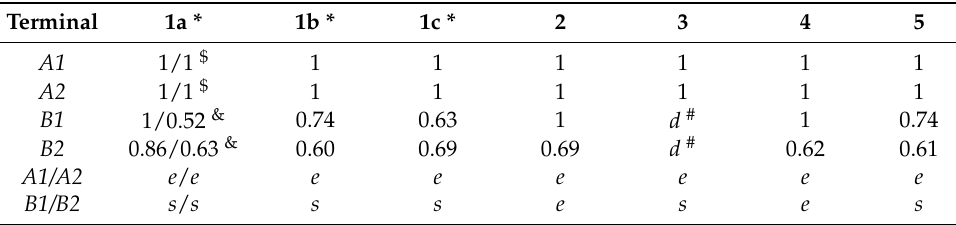
Figure 3. Relative positions in a chain and conformations of terminal ethylene groups for independent BEDT-TTF radical cation A ( left ) and B ( right ) in salt 5 . Main positions for disordered ethylene groups of B are colored cyan and complementary are colored navy. The conformation is eclipsed for A and staggered for B. Thermal ellipsoids are of 50% probability. Table 3. BEDT-TTF radical cation terminal ethylene group occupancies and mutual conformation for the salts 1 – 5 . In the case of disordered groups, the occupancies of the main positions are presented. In the case of completely ordered groups, occupancies are equal to unity. Terminal A 1 is defined as the ethylene group closest to the Fe 3+ ion, A 2—an opposite side of the molecule. Terminals B 1/ B 2 are defined by the same manner in the relation to the NH 4+ ion. Letter e denotes the eclipsed conformation while s denotes the staggered one. An example of e / s conformation is presented in Figure 3. Experiment temperature is 100 K unless otherwise noted.